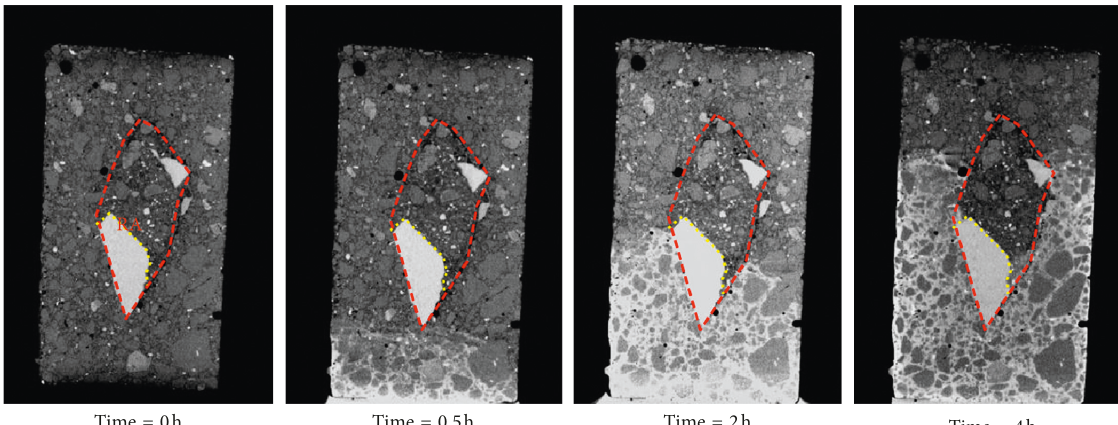
Figure 4: Chloride ion penetration paths in RAC with carbon-conditioned recycled aggregate.